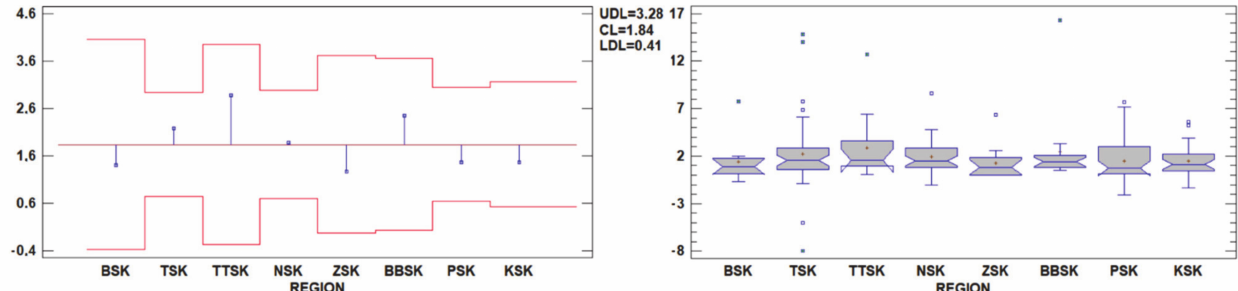
Figure 3. Comparison of the structure of results at the level of individual regions—Altman model, businesses. Legend: BSK— Bratislava region, TSK—Trnava region, TTSK—Trenˇc í n region, NSK—Nitra region, ZSK—Žilina region, BBSK—Bansk á Bystrica region, PSK—Prešov region, and KSK—Košice region; UDL—upper decision limit, CL—central line, LDL—lower decision limit.